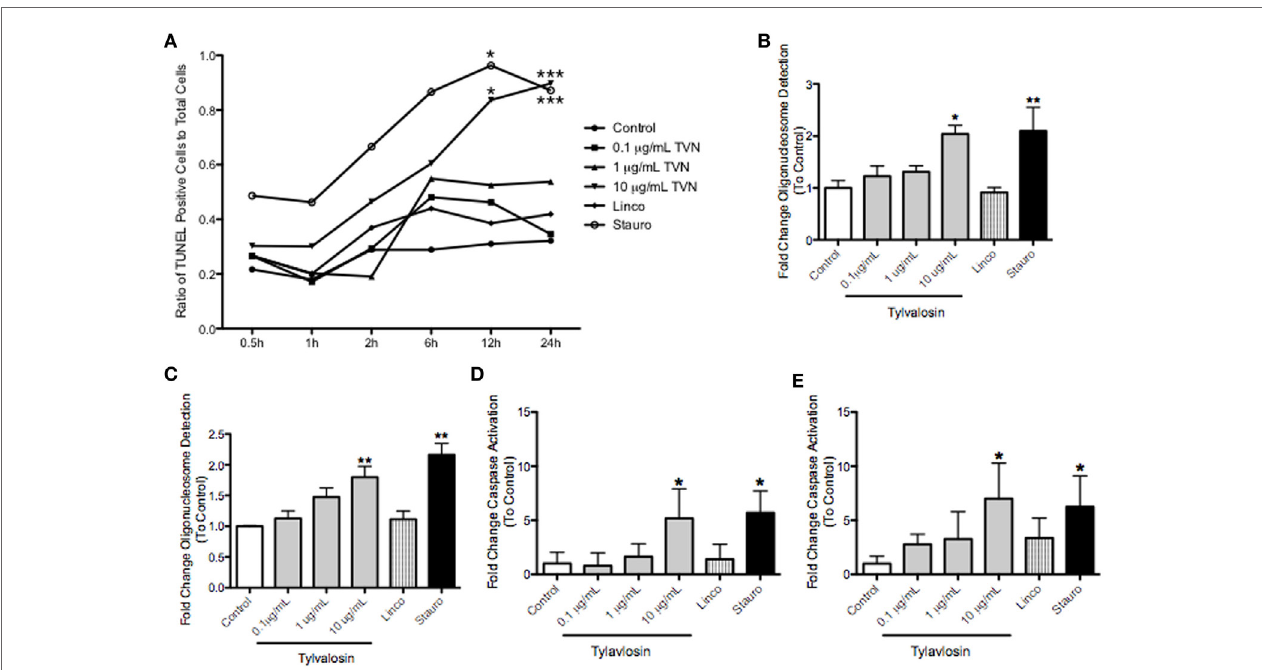
FigUre 2 | Tylvalosin induces apoptosis in porcine macrophages in a time- and dose-dependent manner. Monocyte-derived macropahges were treated with control vehicle (10% FBS in IMDM), tylvalosin (0.1, 1, or 10 μ g/mL), or 1 μ M staurosporine (positive control), or equimolar concentrations (11 μ M) of lincomycin. (a) Tylvalosin-induced macrophage apoptosis is time and dose dependent. Values are reported as ratios of TUNEL stained cells in each image versus those that stained for nuclear DAPI (0.5–24 h). Data are means ( n = 4–8/group) * P < 0.05, *** P < 0.001 versus control. Under the same conditions, a cell-death enzyme-linked immunosurbent assay (ELISA) was performed at (B) 12 and (c) 24 h. The assay is a quantitative measure of cytosolic mono- and olgio-nucleosomes after the induction of cell death. Values were calculated as fold change of absorbance to control. Data are means ± SEM ( n = 3–5/group). * P < 0.05, ** P < 0.01 versus control. Tylvalosin activates caspase-3 in porcine macrophages at 12 (D) and 24 h (e) . Data are means ± SEM ( n = 3–5/group) * P < 0.05 versus control.